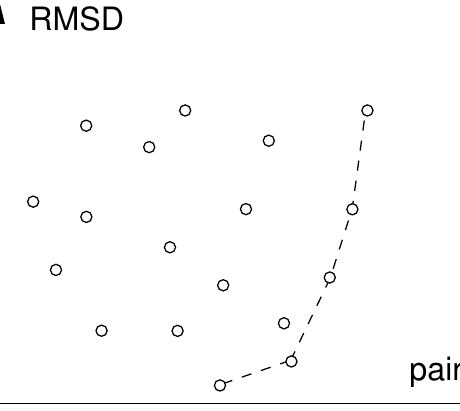
Figure 4. Pareto-front of optimal matches found in database search. The circles connected by broken line are the set of Pareto-optimal matches. All other matches are (unconnected circles) are dominated by one of the members of the Pareto-optimal set as they have both lower RMSD and higher number of matched